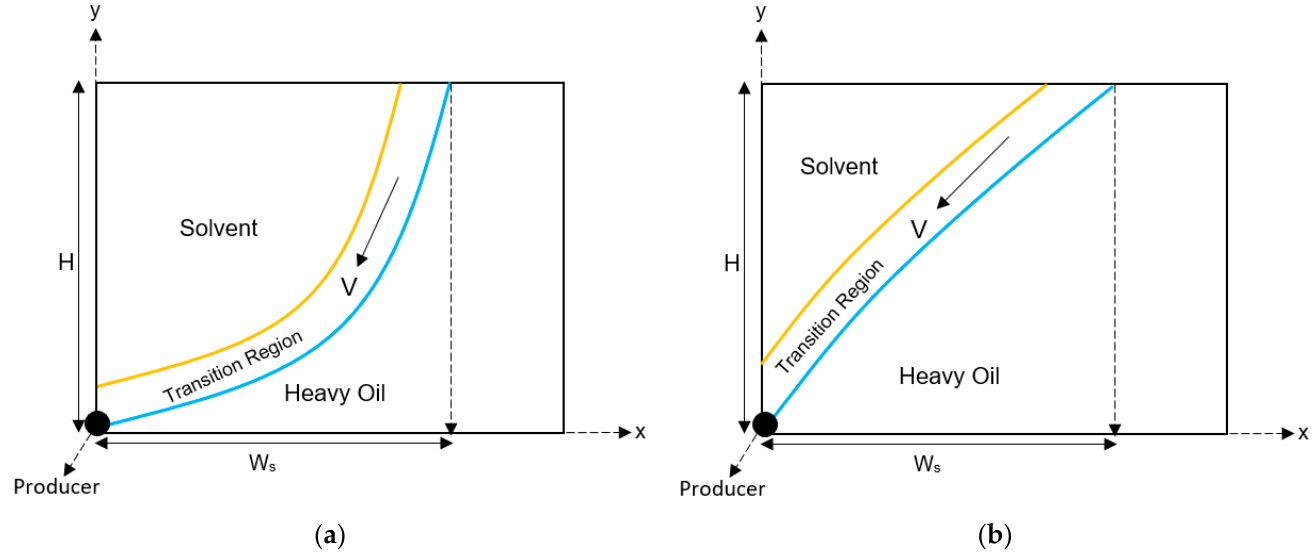
Figure 3. The diluted heavy oil velocity within the transition region of ( a ) concave case and ( b ) convex case.